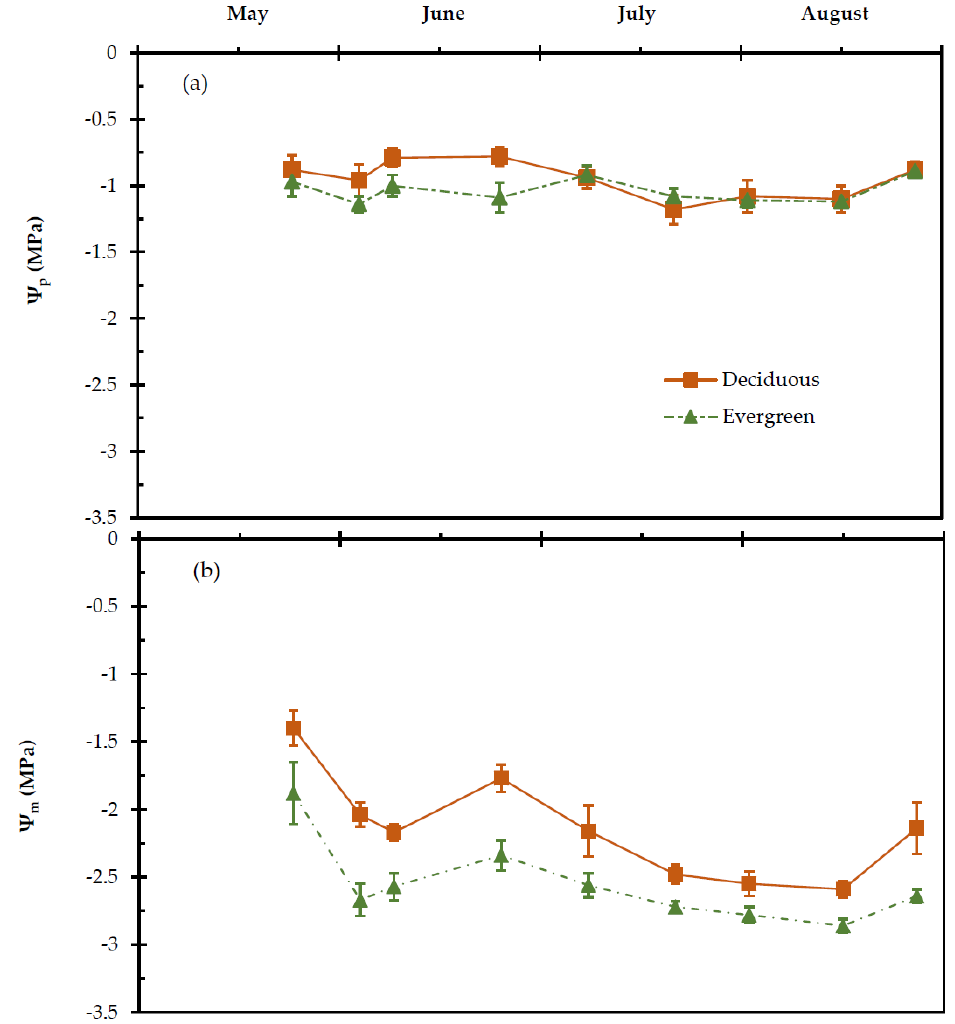
Figure 4. Seasonal ( a ) predawn (Ψ p ) and ( b ) midday (Ψ m ) leaf water potential of deciduous and evergreen shrubs during the experimental period from 27 May to 28 August. The values are means ± SE ( n = 24).